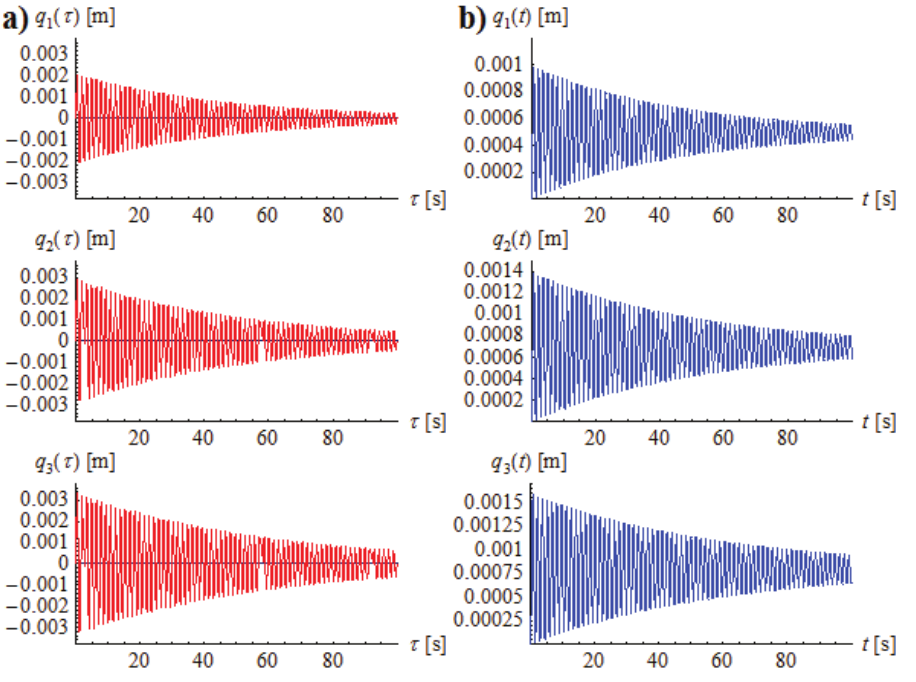
Figure 6: Results obtained from the second measurement: (a) displacement plots in the time domain t ; and b) displacements determined in accordance with formula